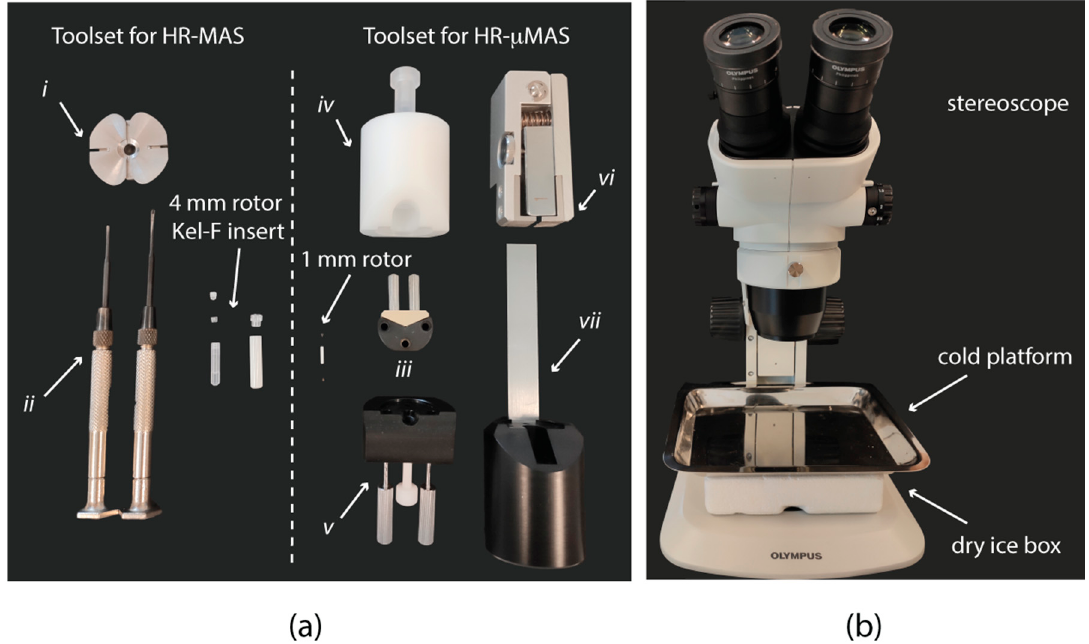
Figure 1. ( a ) Toolsets for (left) high-resolution magic angle spinning (HR-MAS) sample preparation compared to (right) high-resolution micro-magic angle spinning (HR- μ MAS) with details of ZrO 2 rotor of different sizes and packing tools. (i) Clamp tool for opening the rotor cap, (ii) screw drivers for handling Kel-F insert, (iii) μ -rotor holder, (iv) and (v) toolset for closing the μ -rotor caps, (vi) and (vii) toolset for opening the μ -rotor caps. ( b ) Cold workstation and stereomicroscope. A dry ice bucket is placed under a metallic platform, which will be consequently cooled down for allocating the sample manipulations with the μ -rotor under the stereomicroscope.